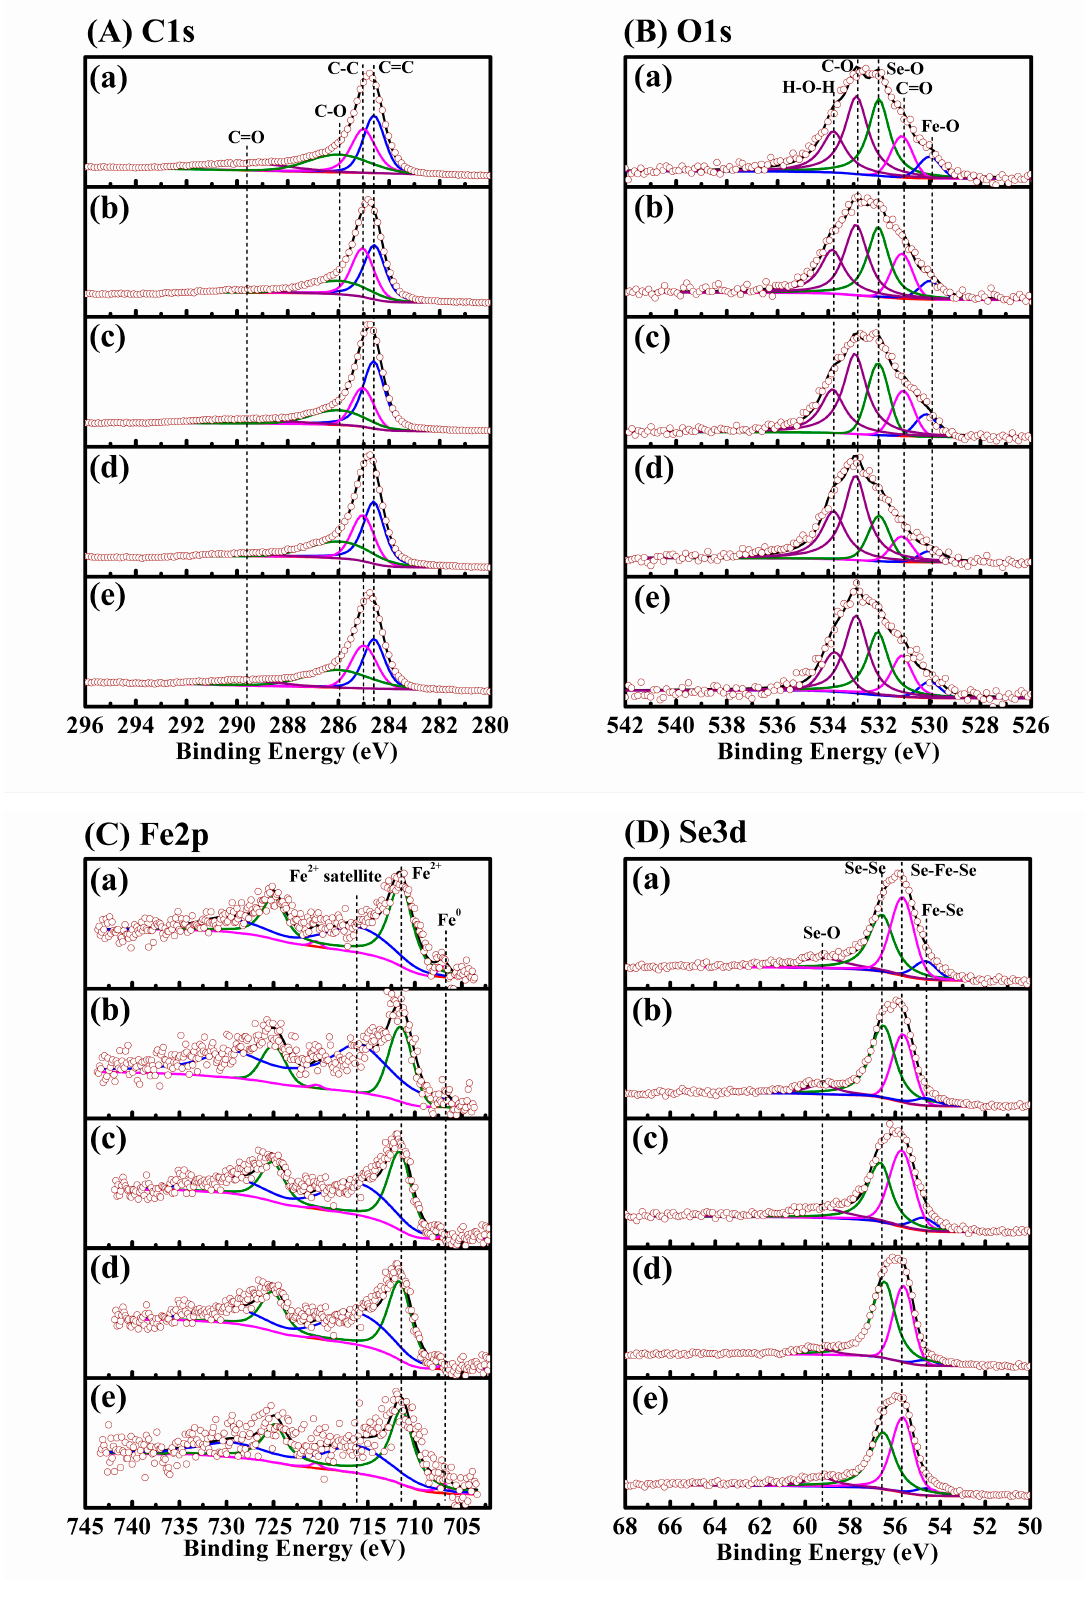
Figure 8. Deconvoluted XPS spectra of ( A ) C1s; ( B ) O1s; ( C ) Fe2p and ( D ) Se3d for FeSe 2 /C prepared with different Se/Fe ratios. ( a ) Se/Fe = 2.0; ( b ) Se/Fe = 2.5; ( c ) Se/Fe = 3.0; ( d ) Se/Fe = 3.5; ( e ) Se/Fe =